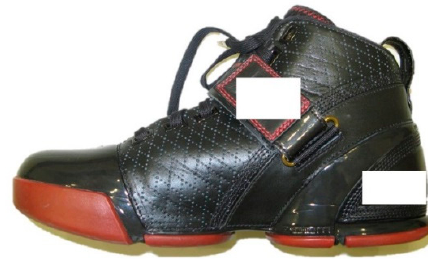
Figure 1. Basketball shoes (shoe N) from a famous international manufacturer.